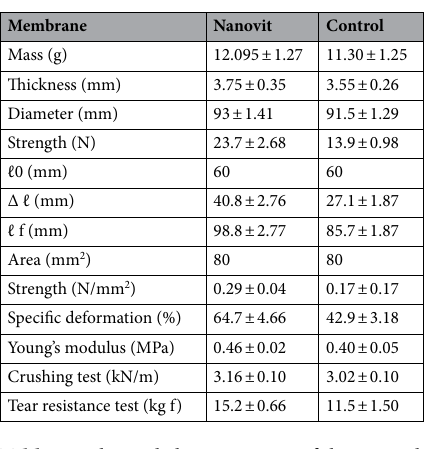
Table 2. Physical characteristics of the control and nanovit membranes.